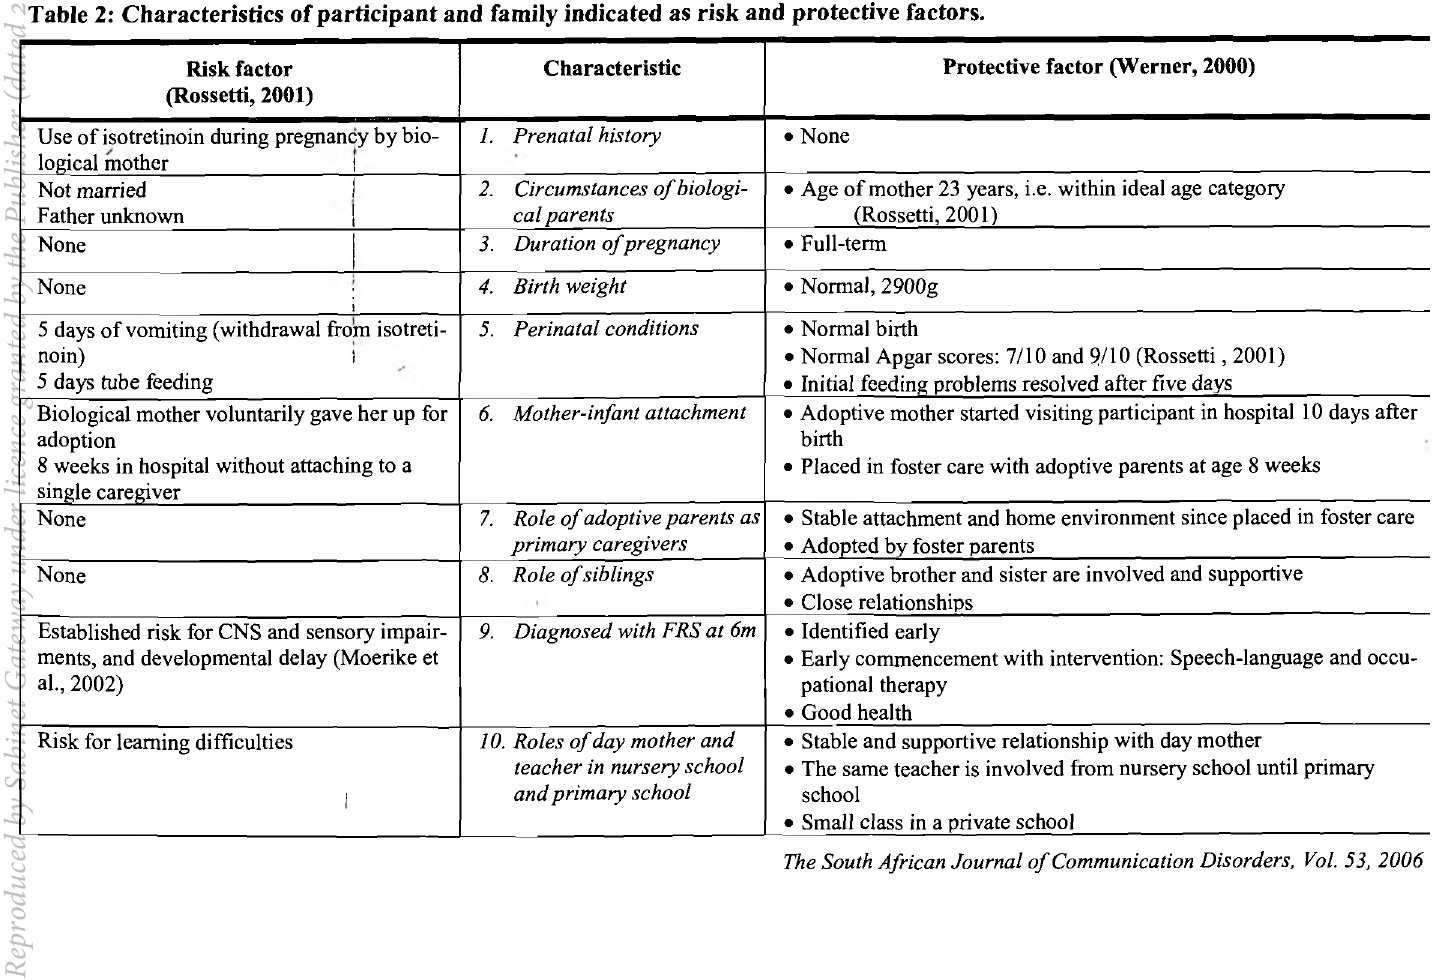
Table 2: Characteristics of participant and family indicated as risk and protective